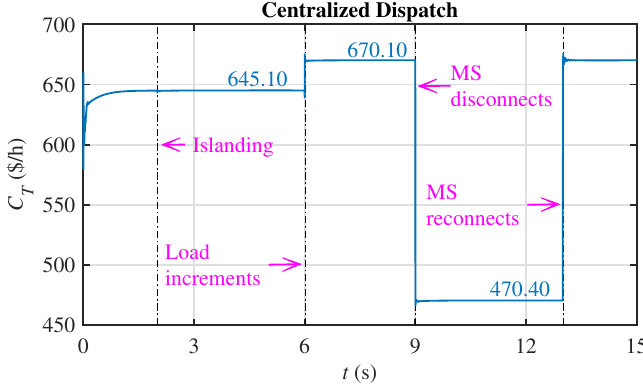
Figure 16. Total generation cost of